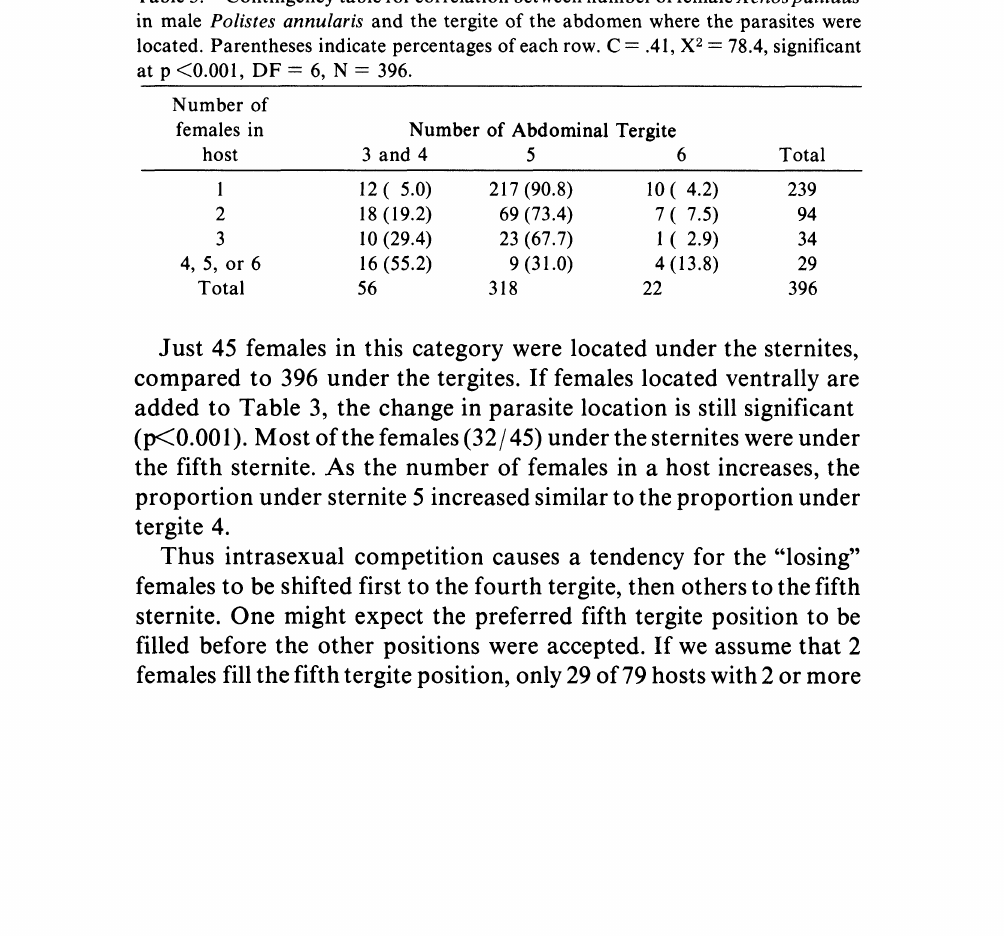
Table 3. Contingency table for correlation between number offemale Xenospallidus in male Polistes annularis and the tergite of the abdomen where the parasites were located. Parentheses indicate percentages of each row.